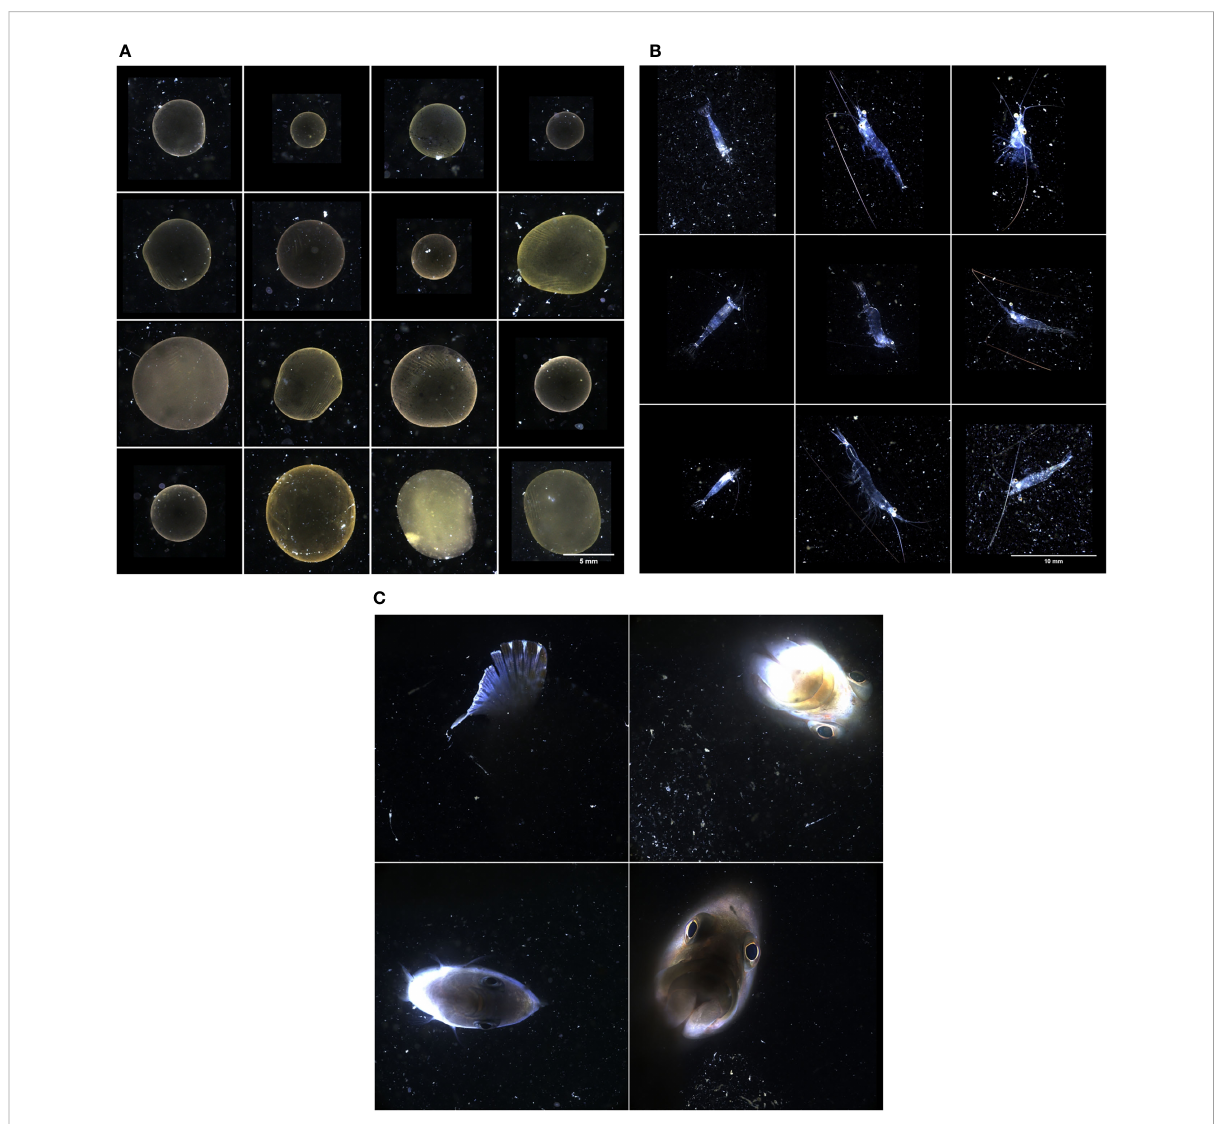
FIGURE 10 Photographs of some disaster-causing organisms (DCOs): (A) Phaeocystis globosa; (B) Acetes chinensis ; (C) small fi sh. * These pictures are from the team of Dr. Li Jianping from the Shenzhen Institute of Advanced Technology, Chinese Academy of Sciences, who provided the optical microscopic